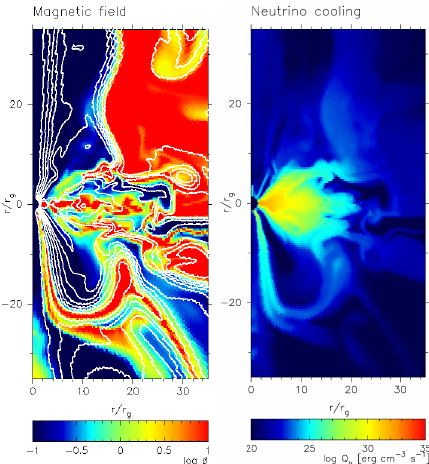
Figure 1. Magnetisation β = P gas / P mag and magnetic field lines topology ( left ), and neutrino emissivity distribution ( right ) in the evolved accretion flow. Snapshots taken at time t = 2000 M. Black hole spin is a =